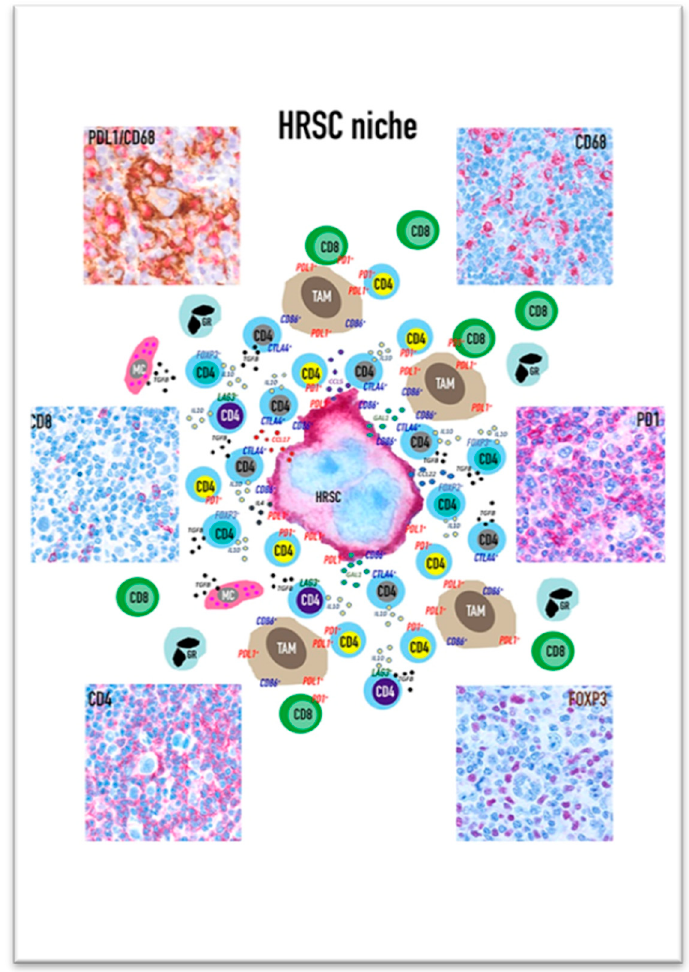
Figure 1. Representation of the Hodgkinian niche with CD30+ HRSC surrounded by several sub- sets of Th-1 and T-reg CD4+ lymphocytes, CD8+ cytotoxic T-cell, tumour associated macrophages (TAMs), granulocytes (GRs) and mast cells